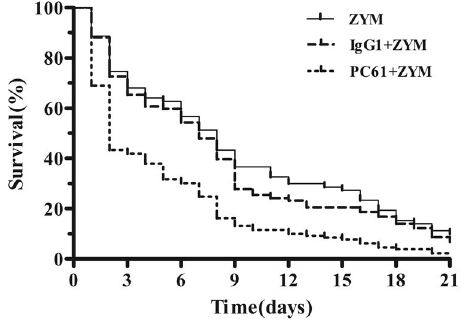
Figure 8. Survival of ZIGI mice with depleted levels of Treg cells. Survival of ZIGI mice that were administered the PC61 mAb. The following groups were analyzed: ZYM (n=80), IgG1 + ZYM (n=80), and PC61 + ZYM (n=80). The survival curves were compared using the logrank test ( P , 0.05).